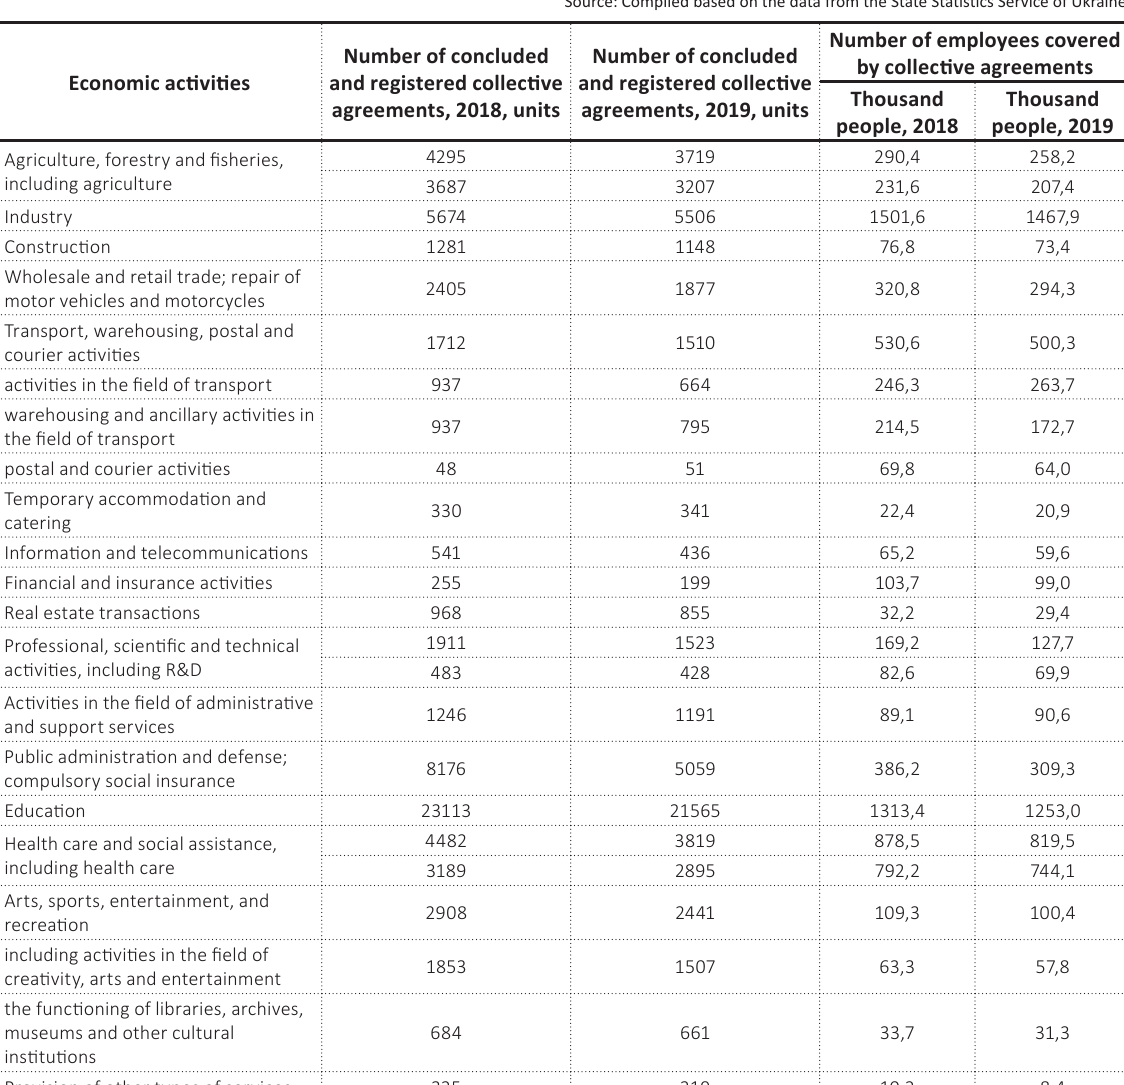
Table 1. Collective agreements and the number of staff covered Source: Compiled based on the data from the State Statistics Service of